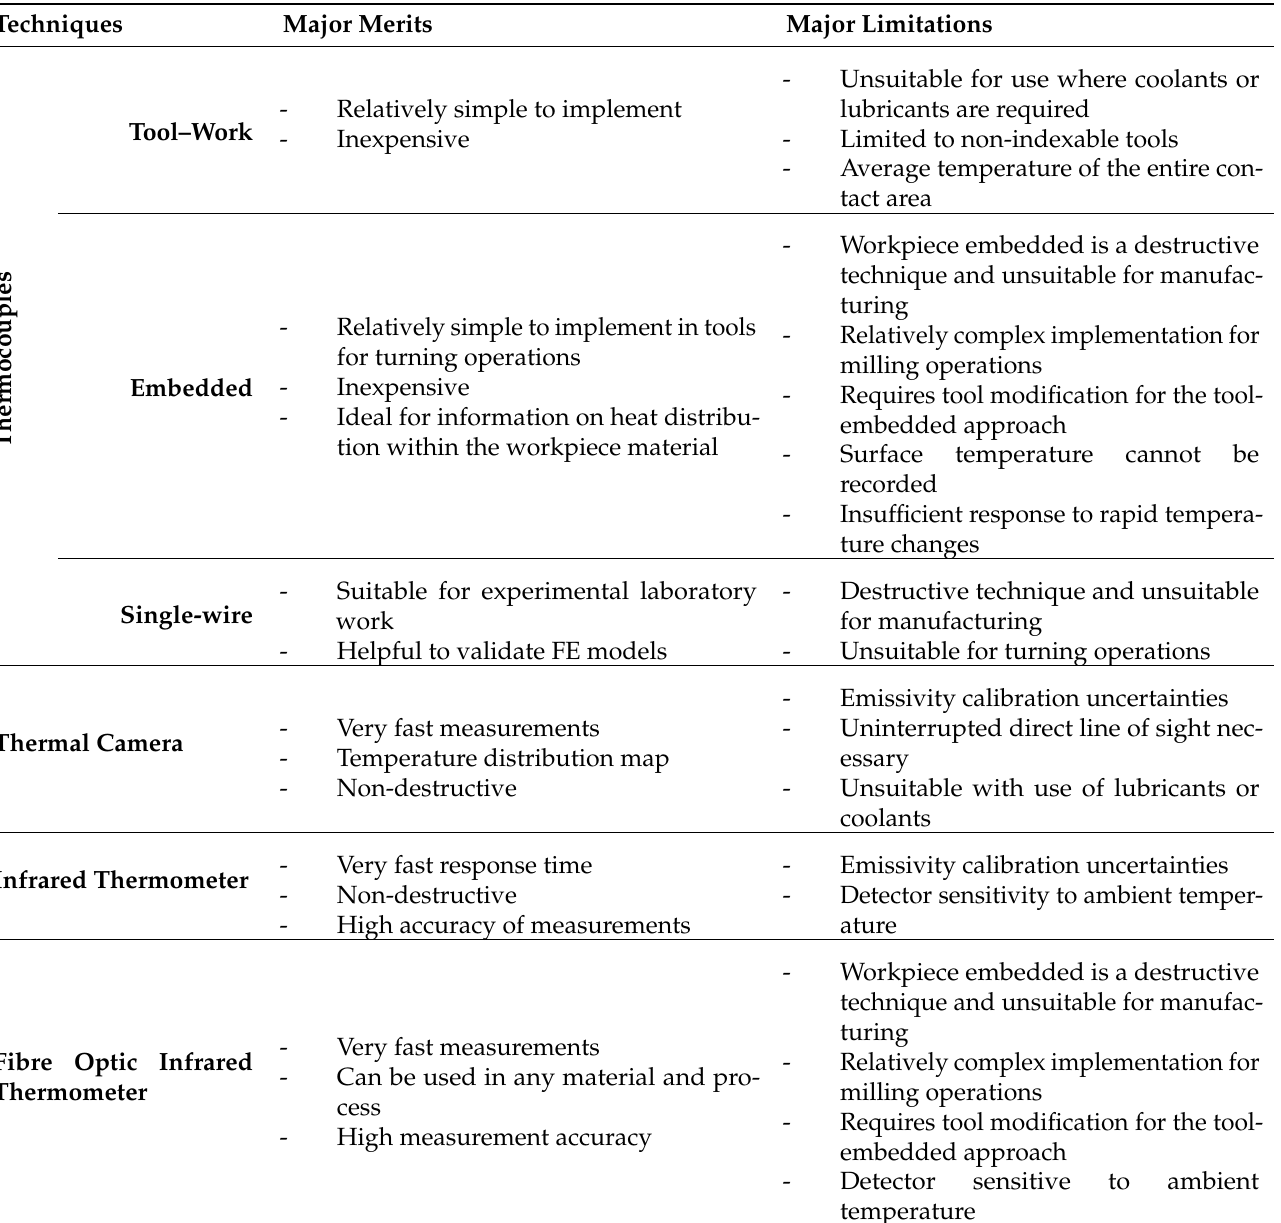
Table 1. Comparative summary of the temperature measurement techniques used in